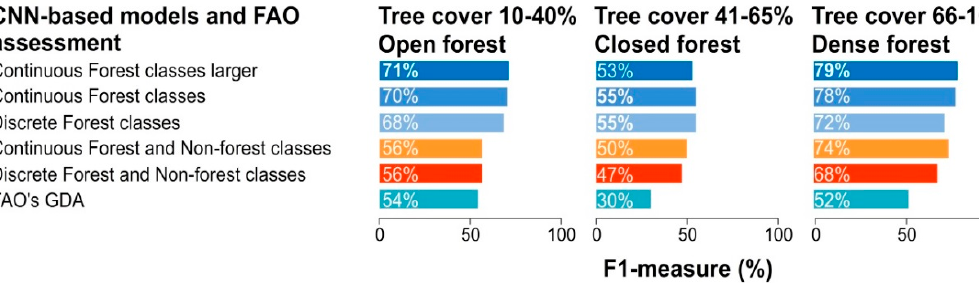
Figure 2. F1-measure of the four CNN models trained and FAO assessment. X-axis shows the F1-measure in percentage. Y-axis represents the experiments of different CNN-based models with the classes Open forest (tree cover 10–40%), Closed forest (tree cover 41–65%), and Dense forest (tree cover 66–100%).